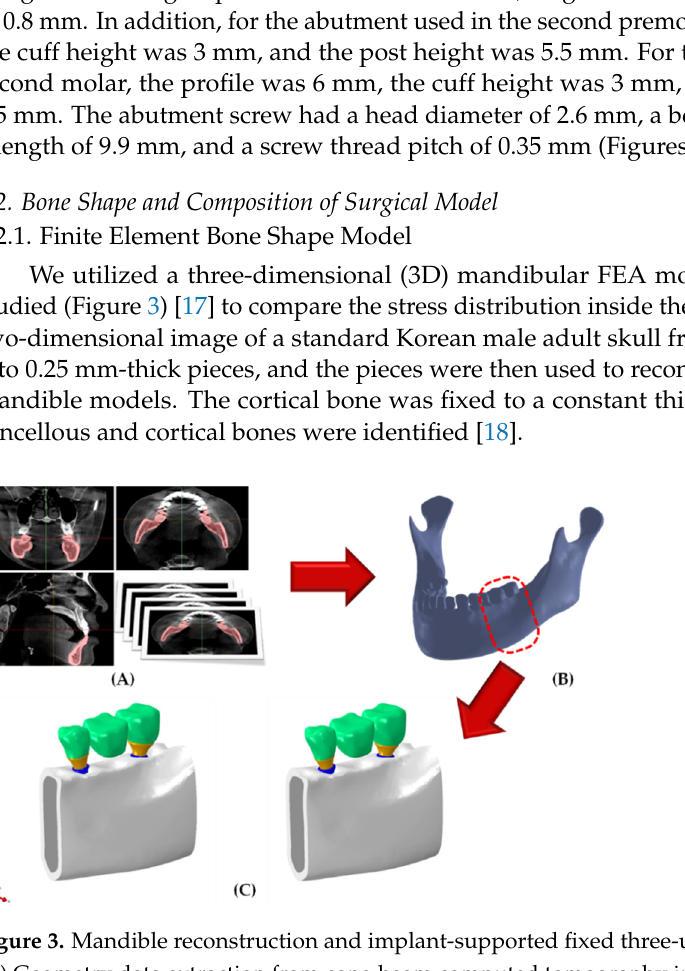
Figure 4. Construction of the finite element surgical model, AnyOne group and BlueDiamond group. 2.3. Material Properties The properties of the components used in this study were based on those used in the previous literature and are listed in Table 1 [19–22] and Table 2. Table 1. Material properties applied to the finite element model. Components